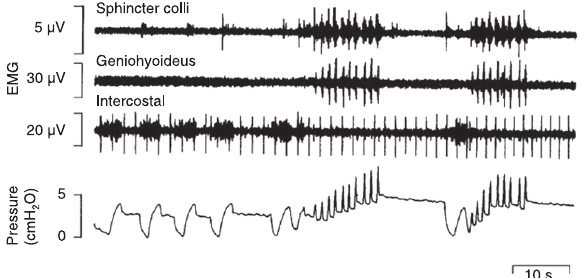
Figure 4. A series of thoracic plus buccal ventilatory cycles re- corded from an anaesthetised Uromastyx aegyptius microlepis using whole body plethysmography. At 30°C, a cycle of thoracic ventilatory cycles terminated in the addition of buccal